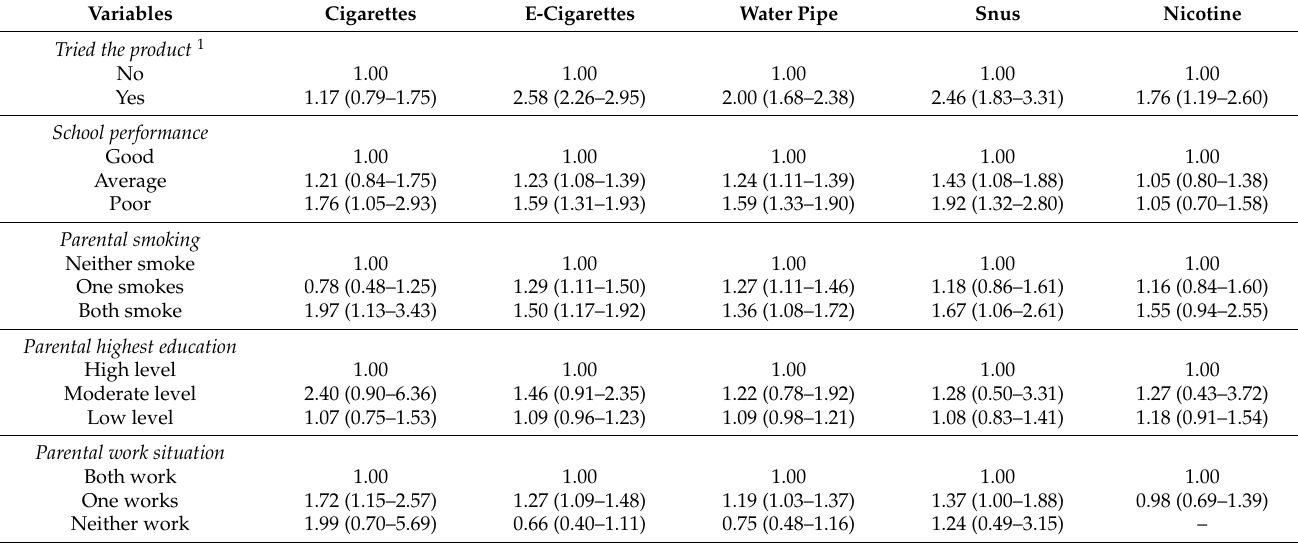
Table 4. Adjusted Odds Ratios (ORs) and 95% CIs for adolescents who reported that cigarettes, e-cigarettes, water pipe, snus, and nicotine are not harmful to health, by experimentation with the product and by socio-economic